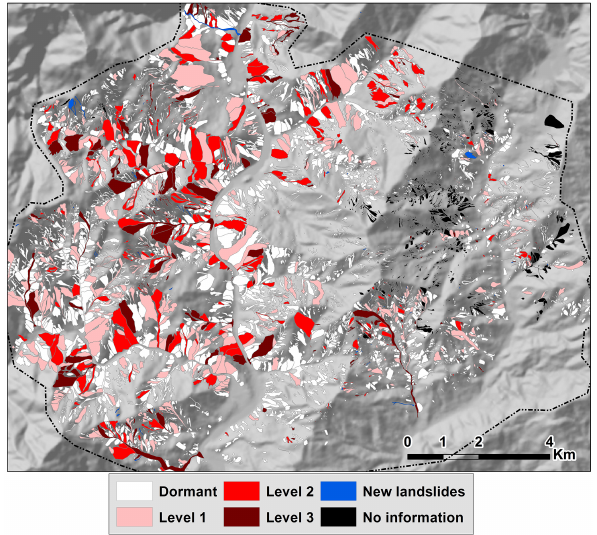
Figure 7. Landslide inventory map based on the image taken in February 2009, reflecting the state of activity after the rainy season of